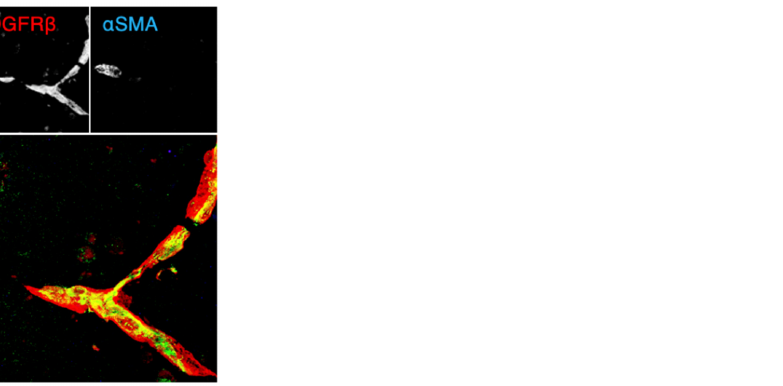
Figure 2. Expression of the 5-HT1A receptor in microvascular pericytes and smooth muscle cells of the normal human PFC. Confocal images of the normal PFC gray matter stained for 5-HT1A, platelet-derived growth factor receptor β (PDGFR β ) and α smooth muscle actin ( α SMA). Scale bars, 100 µm. 2.2. PKA is Activated in Microvascular Endothelial Cells and Mural Cells of the Schizophrenic PFC We subsequently verified which types of microvascular cells in the schizophrenic PFC showed aberrant PKA activation. A strong pPKA signal was detected in the PDGFR β - expressing mural cells (Figure 3A,B). In addition, pPKA was also colocalized with the en- dothelial marker CD34. Moreover, a weak pPKA signal was at least partially colocalized with glial fibrillary acidic protein (GFAP)-expressing glia.